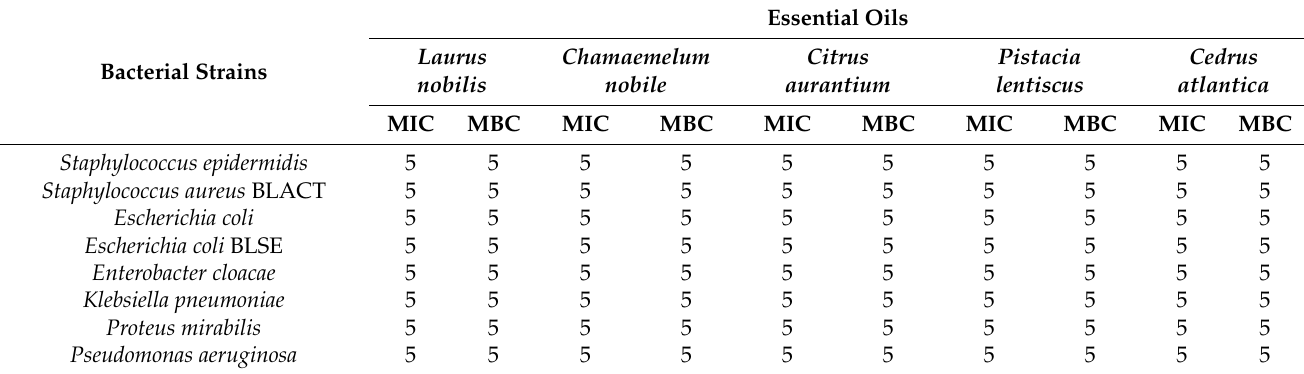
Table 13. MIC and MBC values (mg/mL) of the EOs studied.